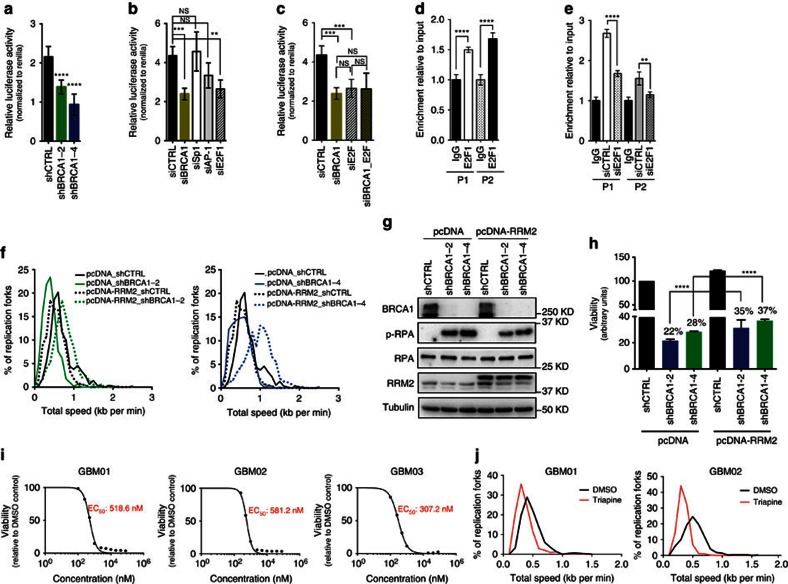
BRCA1 regulates RRM2 expression via E2F1 and RRM2 overexpression rescues BRCA1-loss phenotype in GBM cells.(a) Luciferase assay of transcriptional activation of the RRM2 promoter in GBM01 transduced with shCTRL or shBRCA1-2/shBRCA1-4. (b) Luciferase assay of transcriptional activation of the RRM2 promoter in GBM01 after siRNA-mediated knockdown of Sp1; AP-1 and E2F1 in comparison to BRCA1. (c) Luciferase assay of transcriptional activation of the RRM2 promoter in GBM01 after siRNA-mediated knockdown of BRCA1 and E2F1 alone or on combination. (d) Chip immunoprecipitation of E2F1 binding RRM2 promoter in GBM01 cells using primer set P1 and P2. (e) Chip immunoprecipitation of BRCA1 binding RRM2 promoter in GBM01 cells transfected with siCTRL and siE2F1 using primer set P1 and P2. (f) DNA fibre assay measuring the replication fork progression speed in GBM cells lacking BRCA1 (shBRCA1-2 and shBRCA1-4) or not (shCTRL) transfected with either control vector (pcDNA) or vector expressing RRM2 (pcDNA-RRM2). See also Table 3. (g) Cell viability of GBM cells lacking BRCA1 (shBRCA1-2 and shBRCA1-4) or not (shCTRL) transfected with either control vector (pcDNA) or vector expressing RRM2 (pcDNA-RRM2). (h) Immunoblot analysis of BRCA1, p-RPA, RPA and RRM2 in GBM cells lacking BRCA1 (shBRCA1-2 and shBRCA1-4) or not (shCTRL) transfected with either control vector (pcDNA) or vector expressing RRM2 (pcDNA-RRM2). (i) Viability-based assessment of EC50 triapine concentrations in GBM01, GBM02 and GBM03 cells. (j) DNA fibre assay measuring the replication fork progression speed in GBM cells treated with DMSO or EC50 triapine. See also Table 4. Statistical significance was calculated by one-way ANOVA and Tukey’s multiple comparisons test in a–d,f,h or Student’s t test (e,i) and all data are shown as means ±s.d. and performed as technical triplicates. (*P<0.05, **P<0.005, ***P<0.005, ****P<0.0001; NS represents non-significance).